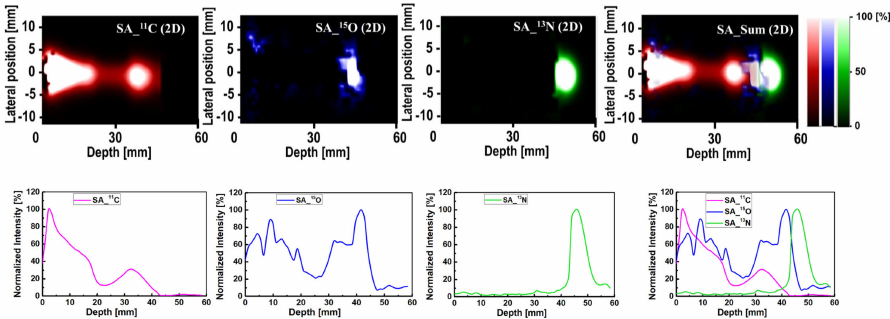
Figure 6. The 2D ( first row ) and 1D ( second row ) profile of the SA output 11 C, 15 O and 13 N radioiso- topes and their sum (color in 2D plot corresponds to those in 1D profiles).